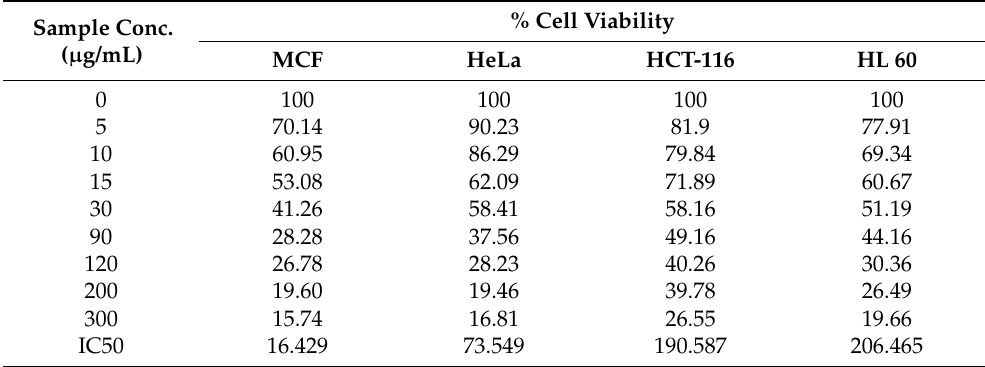
Table 2. In vitro cytotoxicity assay of purified compound from Leucas indica against selected cancer cell lines.